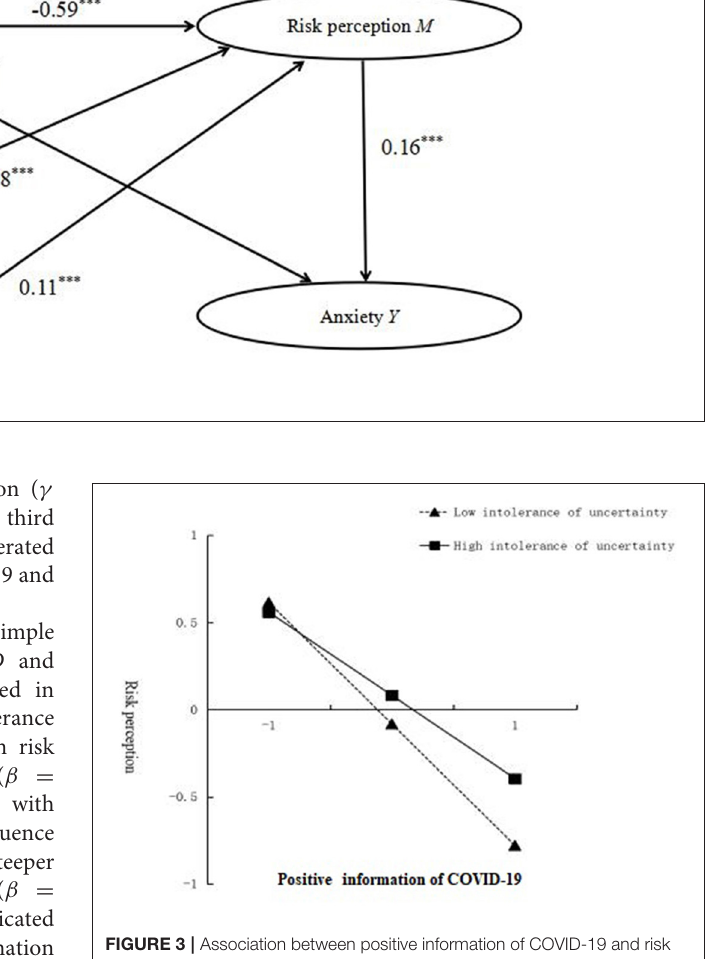
they used data from the European Audiovisual Observatory Yearbook 15 to obtain national estimates of average TV viewing per person per day, but anxiety was measured using